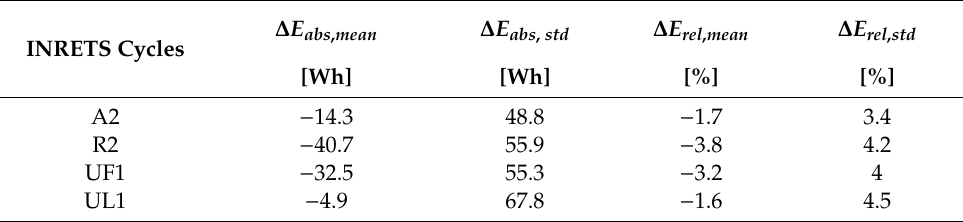
Figure 17. (cid:1842)(cid:1839)(cid:1848) (cid:3045)(cid:3040)(cid:3046) versus HVAC consumed energy for DP (black line) and the real-time algorithm (colored points)—Results for (cid:1846) (cid:3032)(cid:3051)(cid:3047),(cid:2868) = 37 °C , (cid:1834)(cid:1844) (cid:3032)(cid:3051)(cid:3047),(cid:2868) = 35% , (cid:1869)(cid:4662) (cid:3046)(cid:3048)(cid:3041),(cid:2868) = 500 W and the R2 driving cycle. We have chosen to quantify the performance of the proposed TCMS by the average vertical distance between the colored points and the Pareto frontier. This distance is denoted by ∆(cid:1842)(cid:1839)(cid:1848) (cid:3005)(cid:3017) . The smaller it is, the better the real-time algorithm performs. Figure 18 summarizes the results for the R2 driving cycles. The curves show the evolution of ∆(cid:1842)(cid:1839)(cid:1848) (cid:3005)(cid:3017) , as a function of the external temperature, for different conditions of humidity and insolation. The average value is 0.15 , and we notice that this difference increases in warm and sunny conditions. Similar results are obtained for the other driving cycles, but we prefer not to present them here since they show same behavior.